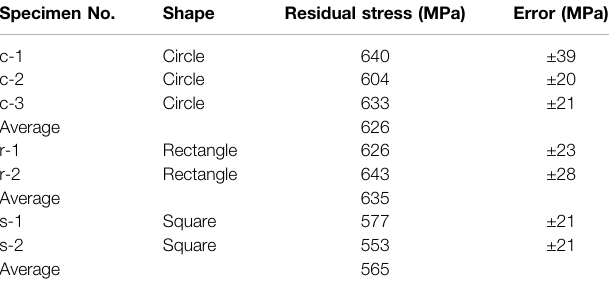
TABLE 2 | List of the estimated residual stresses in the electrolyte for small cells. Specimen